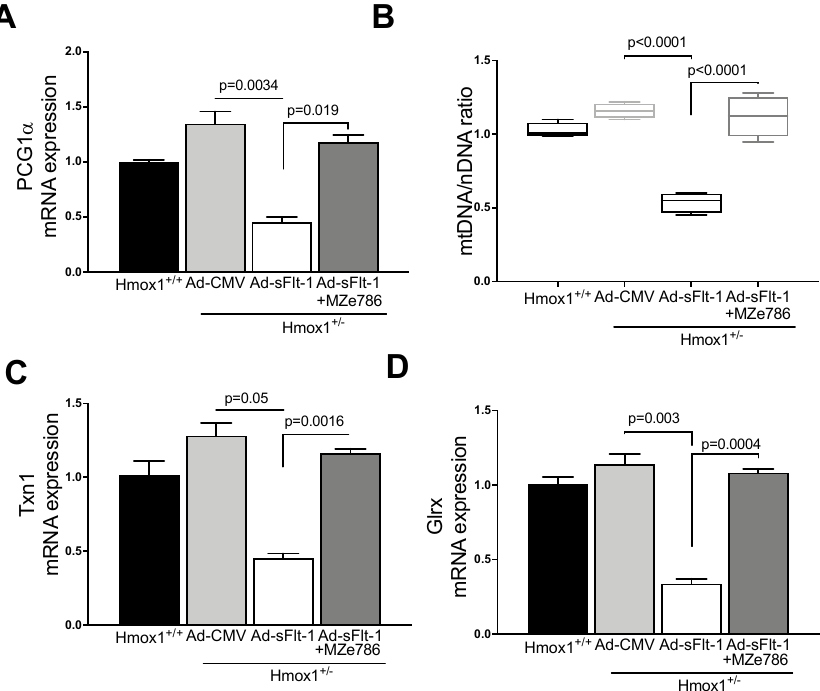
Figure 4. MZe786 stimulates the cardiac mitochondrial biogenesis and antioxidant defense in Hmox1 +/ − mice in high sFlt-1 environment. ( A ) Relative PGC1 α mRNA expression, ( B ) content of mitochondria expressed as the ratio of mitochondrial DNA by nuclear DNA (mtDNA / nDNA). ( C ) Relative mRNA expression of antioxidant gene thioredoxin (Txn1) and ( D ) glutaredoxin (Glrx) measured by qPCR in heart tissue from Ad-sFlt-1 and Ad-CMV injected Hmox1 +/ − exposed to MZe786 via gavage. A, C and D values are expressed as means ± SEM. Values in B are expressed as median and whiskers represent maximum and minimum Values. N = 4